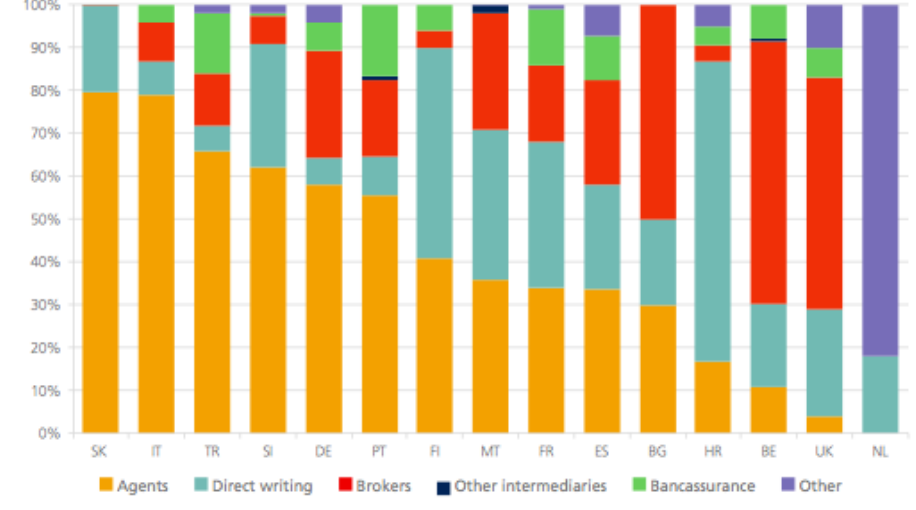
Fig. 2. Non-Life distribution channels in 2014 (% of GWP) Source: Insurance Europe (2016, p.